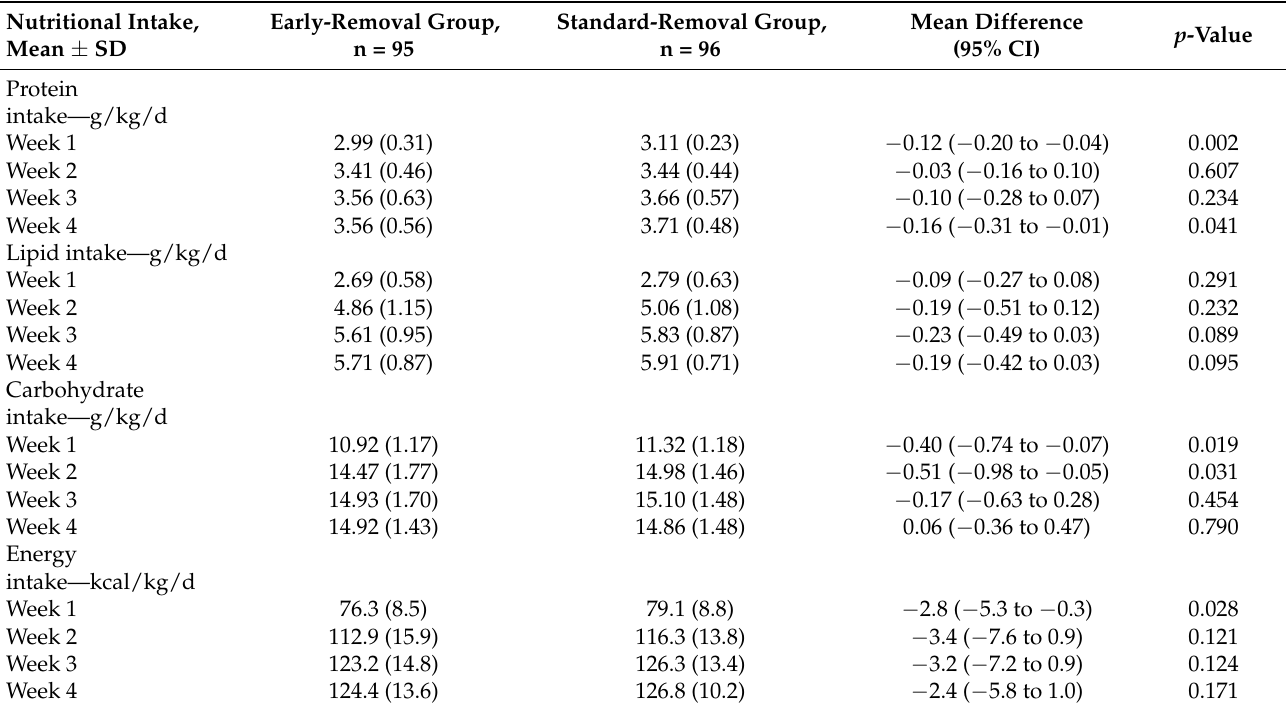
Table 4. Nutritional intake in weeks 1–4.